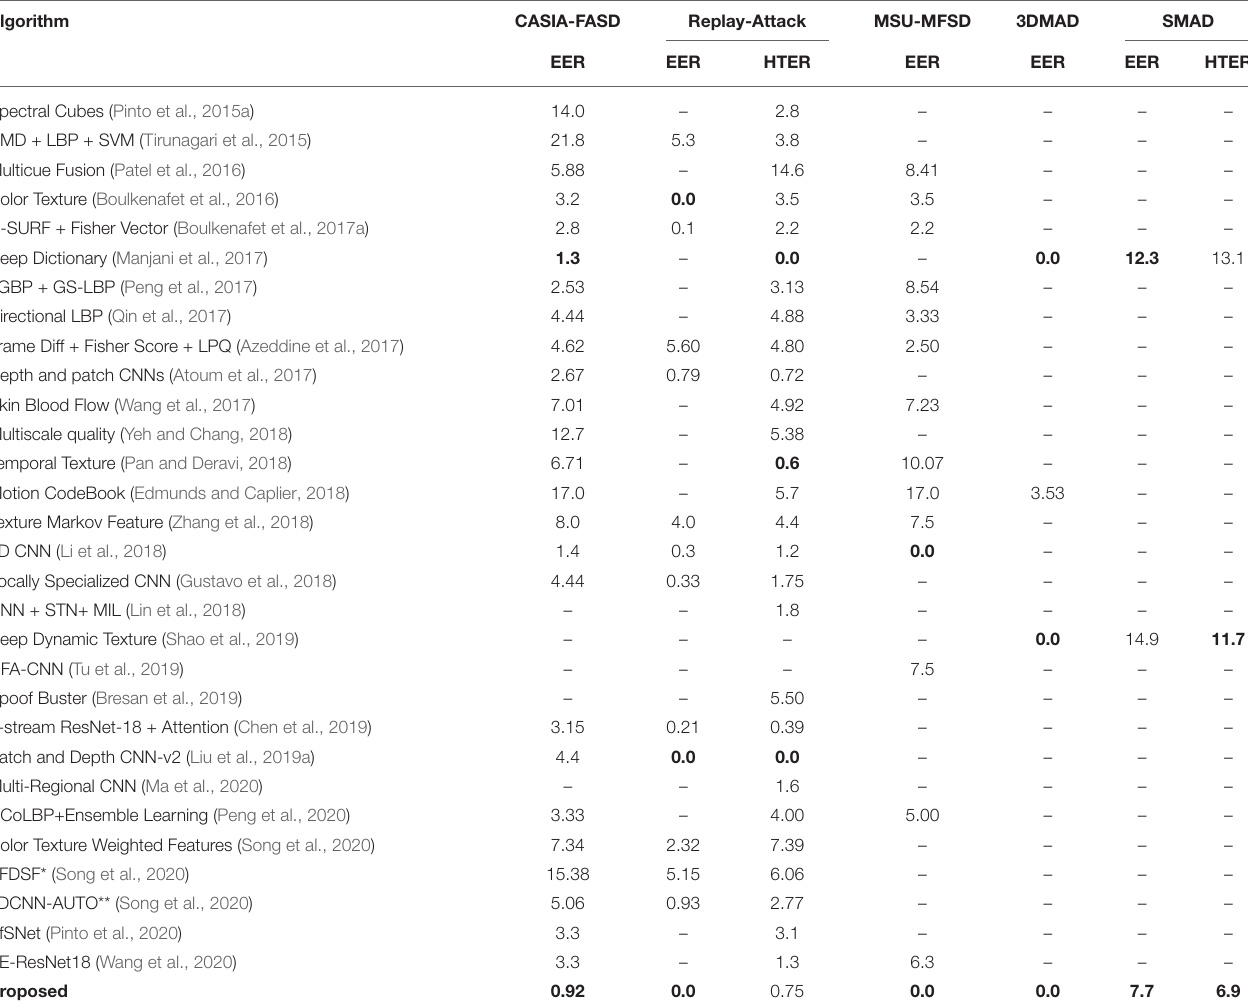
TABLE 7 | Comparison with existing results on the video based presentation attack